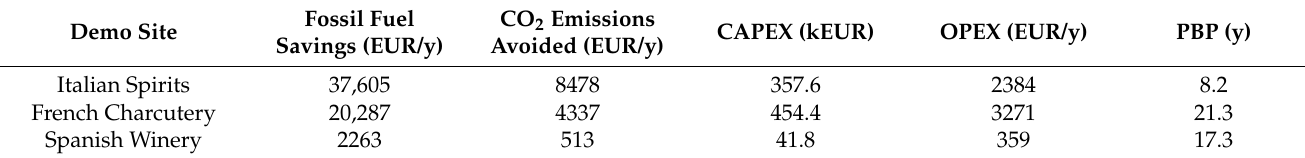
Table 6. Economic indicators for the SHIP integration in the evaluated agri-food industry demo